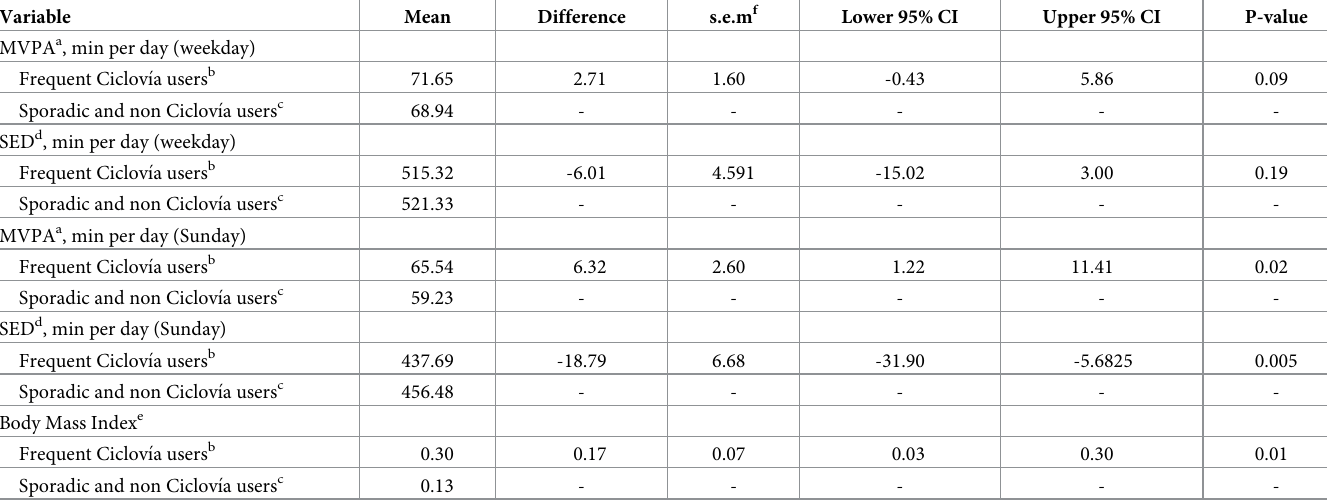
Table 3. Adjusted mean minutes of weekday and Sunday MVPA, SED and adiposity by Ciclovı´a